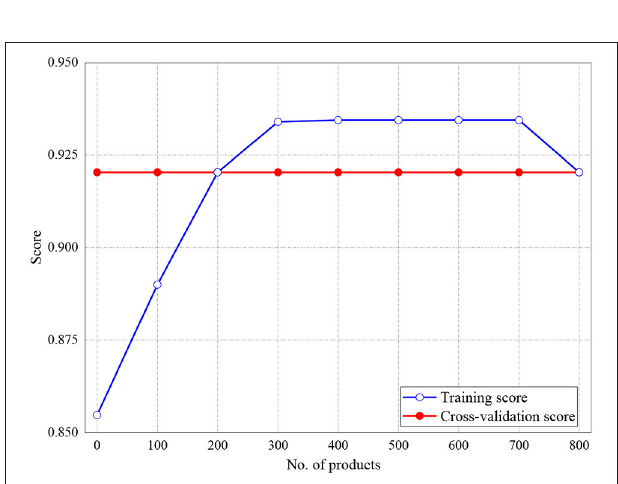
FIGURE 4 | Result for Training and Cross-Validation Scores of Logistic Regression